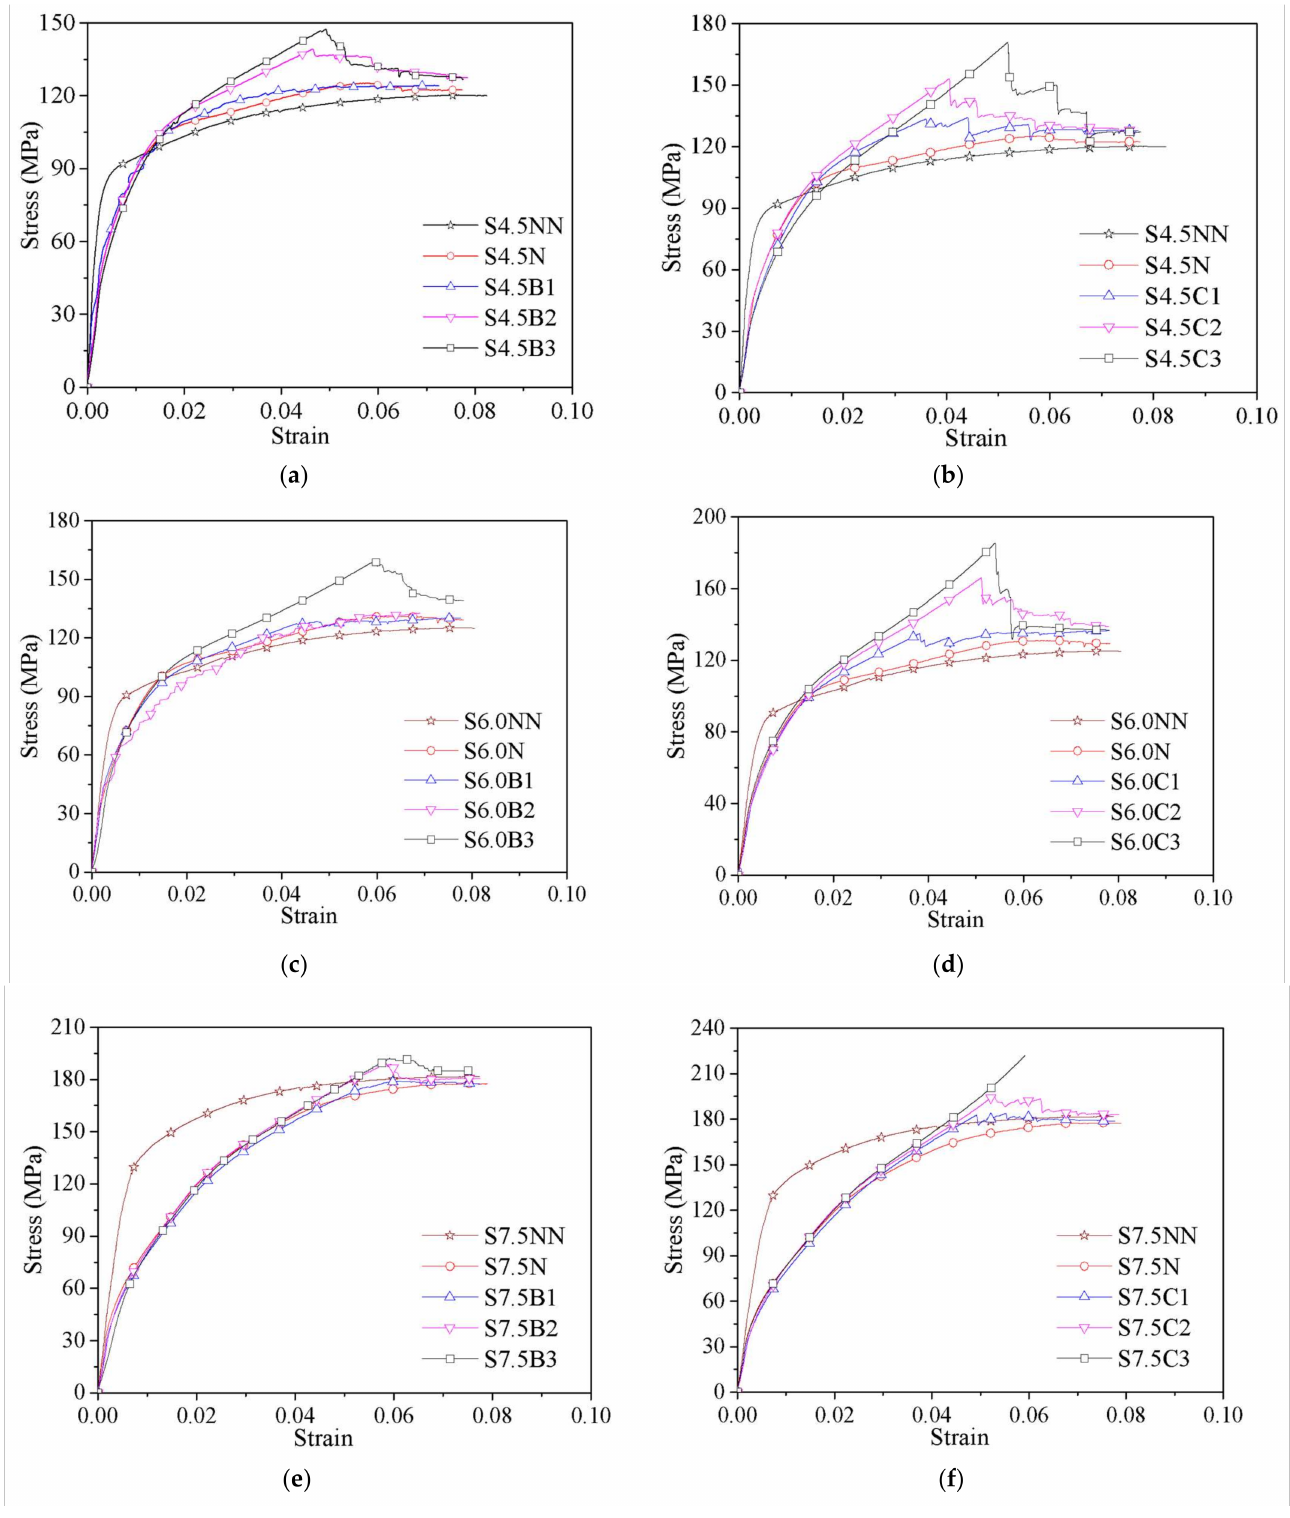
Figure 5. Stress-overall strain curves of the specimens. ( a ) S4.5B series. ( b ) S4.5C series. ( c ) S6B series. ( d ) S6C series. ( e ) S7.5B series. ( f ) S7.5C